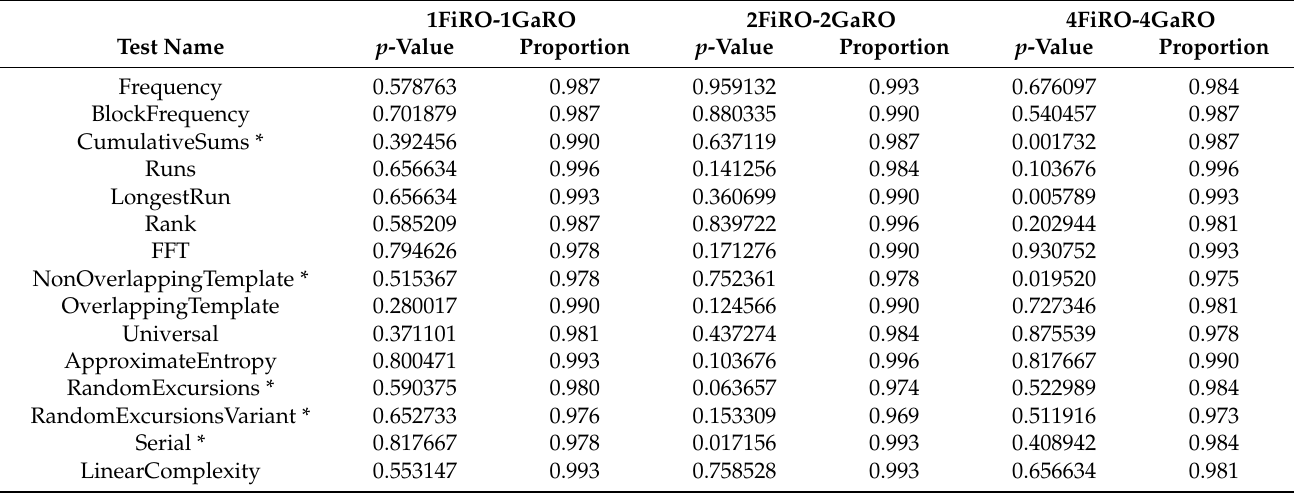
Table 6. NIST 800.22 Statistical Test Results with 50 MHz of Sampling Rate. * Worst case reported for tests with multiple outcomes. 1FiRO-1GaRO 2FiRO-2GaRO 4FiRO-4GaRO